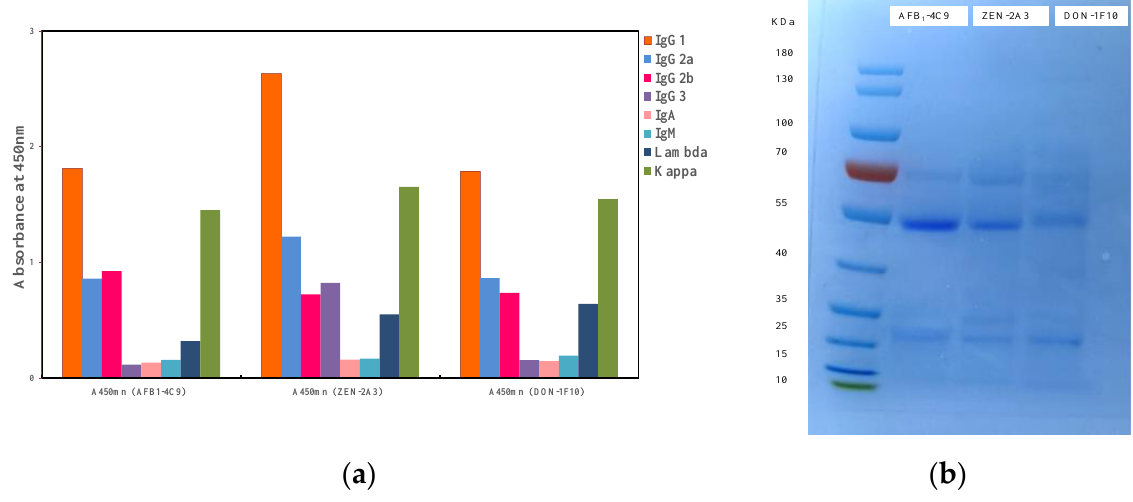
Figure 3. ( a ) Isotype determination of MAb; ( b ) The electropherogram of Mab.